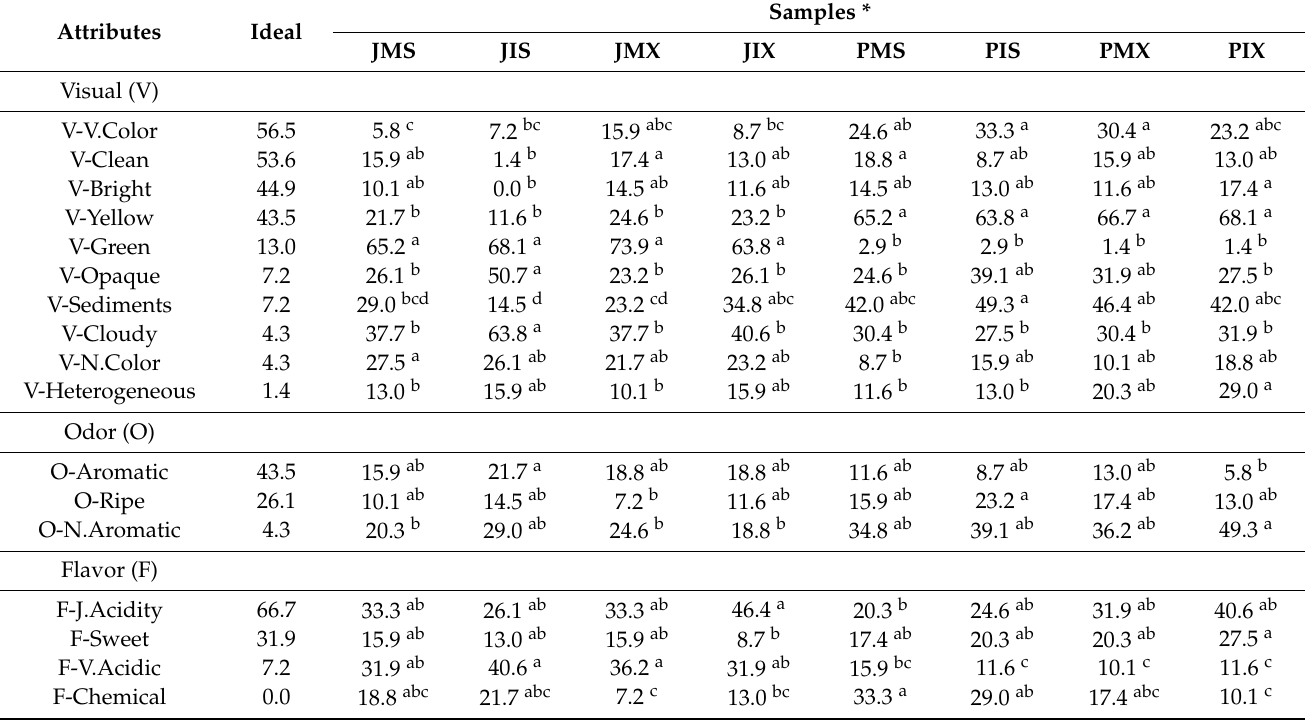
Table 3. Frequency of selection (%) for attributes for which a statistically significant difference ( p < 0.05) among samples was found by using Cochran’s Q